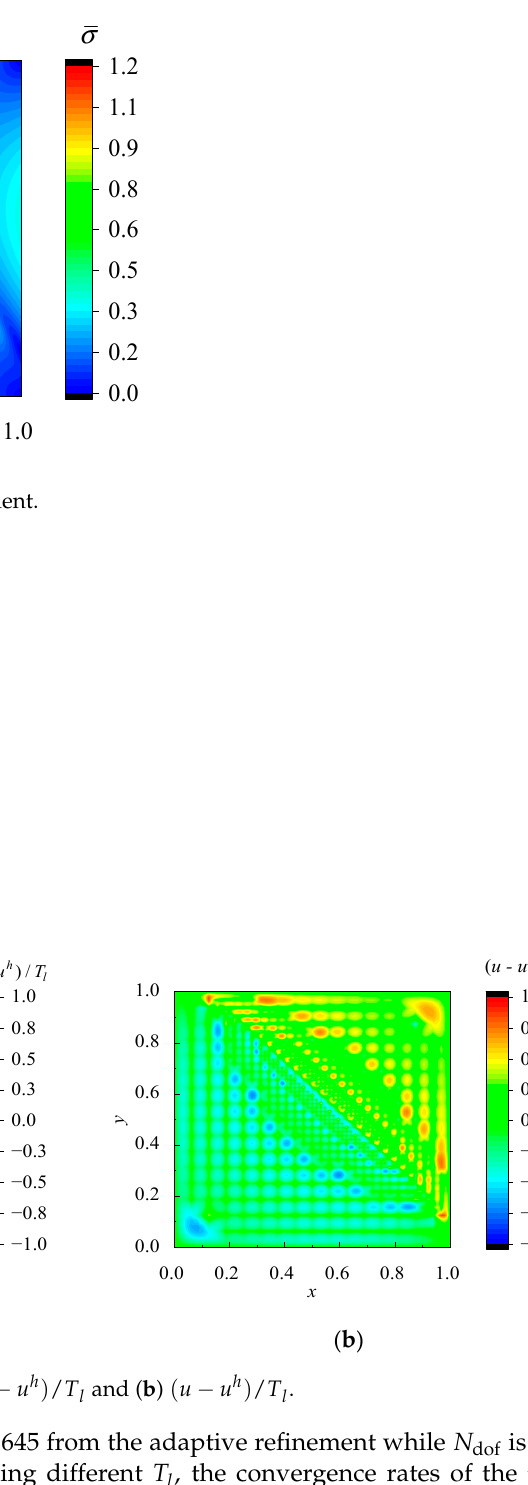
Figure 17. E rror distributions of ( a ) Figure 17. Error distributions of ( a ) ( (cid:101) u ∗ − u h ) / T b ) ( u − u h ) / T l and ( l . Setting T l = 10 − 3 , N dof is only 645 from the adaptive refinement while N dof is N is only 645 from the adaptive refinement while N is 1856 T − = , Setting 3 10 l dof dof T , the convergence rates of the three re- from the uniform refinement. Giving different l finement schemes are calculated as shown in Error! Reference source not found. , where, for comparison, the adaptivity results using cubic elements computed by Dong [22] are also plotted. It is supposed that the optimal adaptive convergence rate [22,26] should be